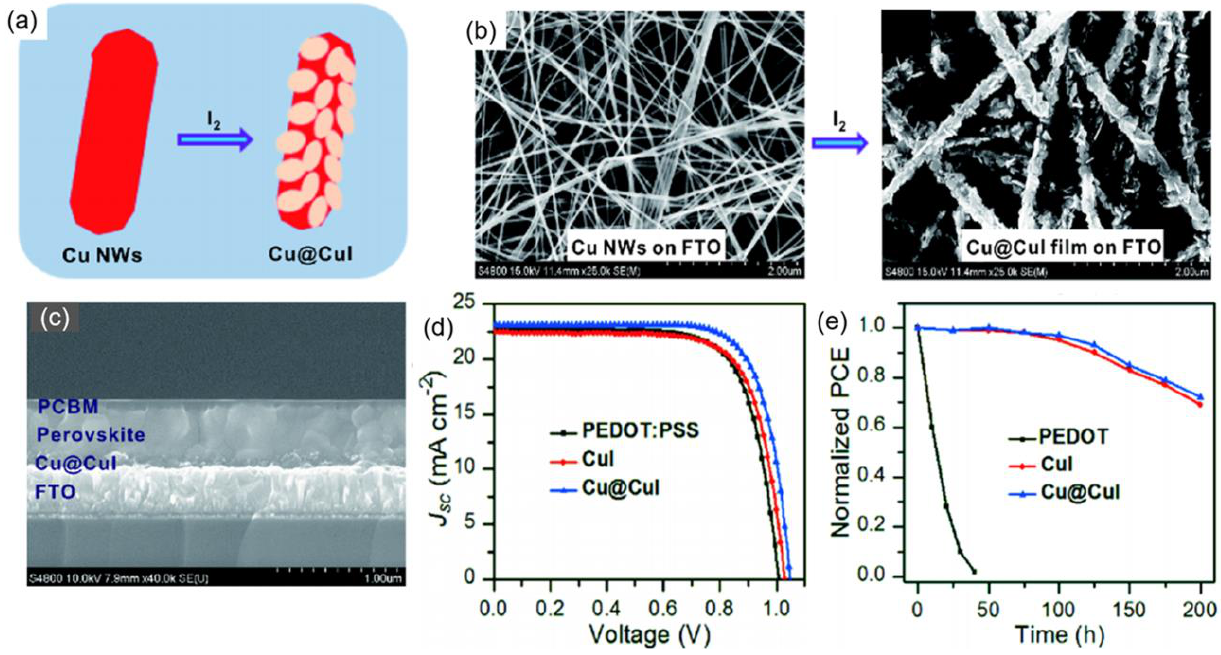
Figure 11. ( a ) Schematic diagram of the transformation of Cu NWs to Cu@CuI nanocomposite in I 2 /ethanol solution; ( b ) top-view SEM image of Cu NWs and Cu@CuI nanocomposite on FTO substrate; ( c ) cross-sectional SEM image of Cu@CuI nanocomposite HTL-based PSC; ( d ) J–V curves and ( e ) ambient stability of PSCs with Cu@CuI, CuI and PEDOT:PSS as HTLs. Reproduced from [133], with permission from the Science China Chemistry, 2019.